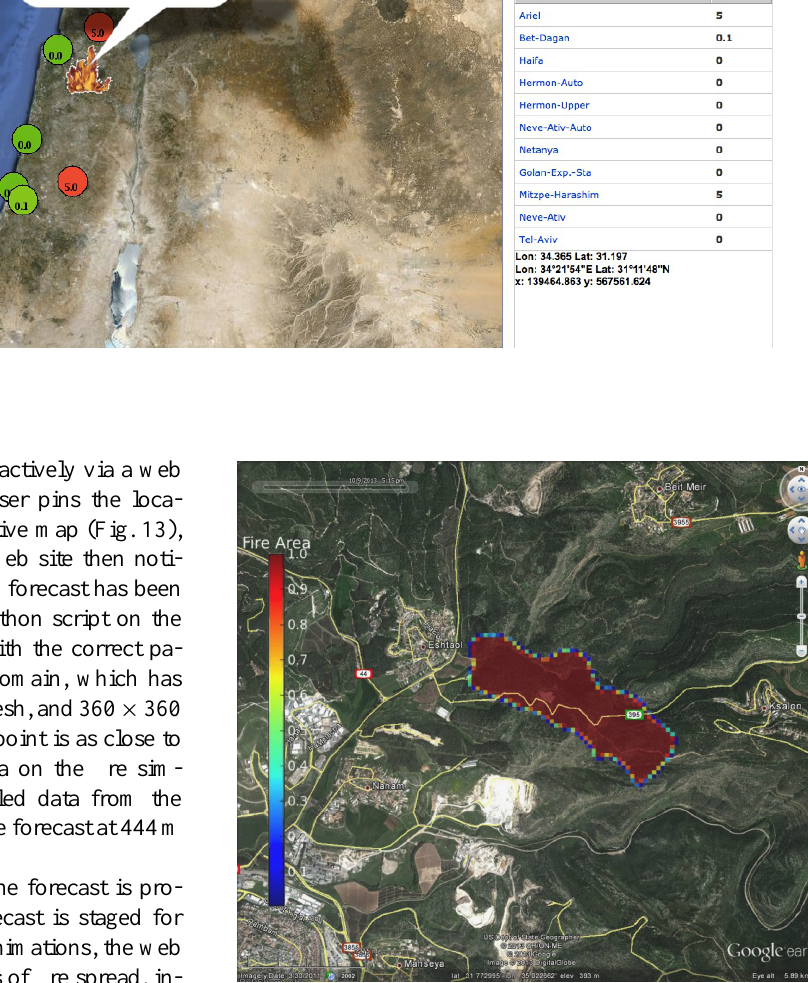
Figure 14. Fire area and fire-line forecast for the fire area of a real fire that was ignited at 11:15LT, 9 October 2013. Fire area value of 1.0 means that the whole grid cell is